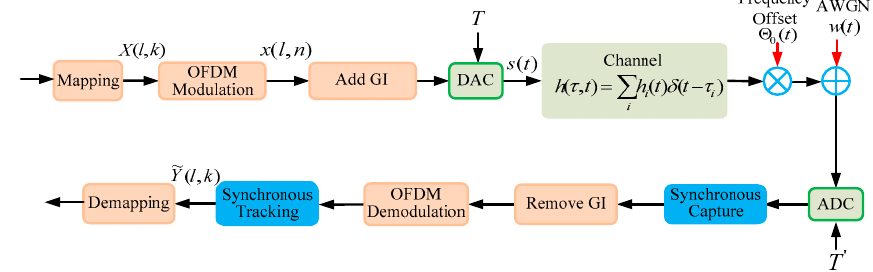
Figure 1. Orthogonal frequency division multiplexing ultra-wideband (OFDM-UWB) baseband transmission model.